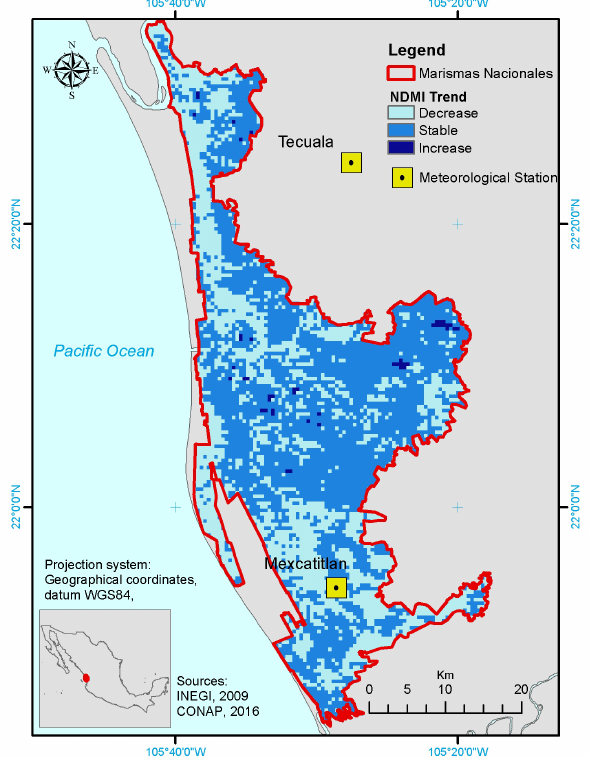
Figure 10. Trends for 10-day normalized difference moisture index (NDMI) composite during